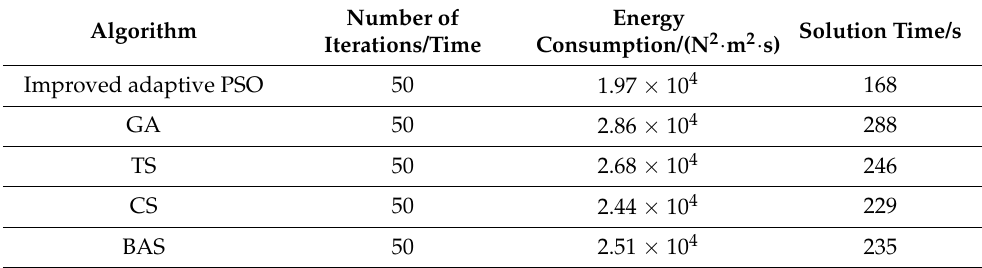
Table 3. The average solving time of the different algorithms compared with the minimum energy consumption